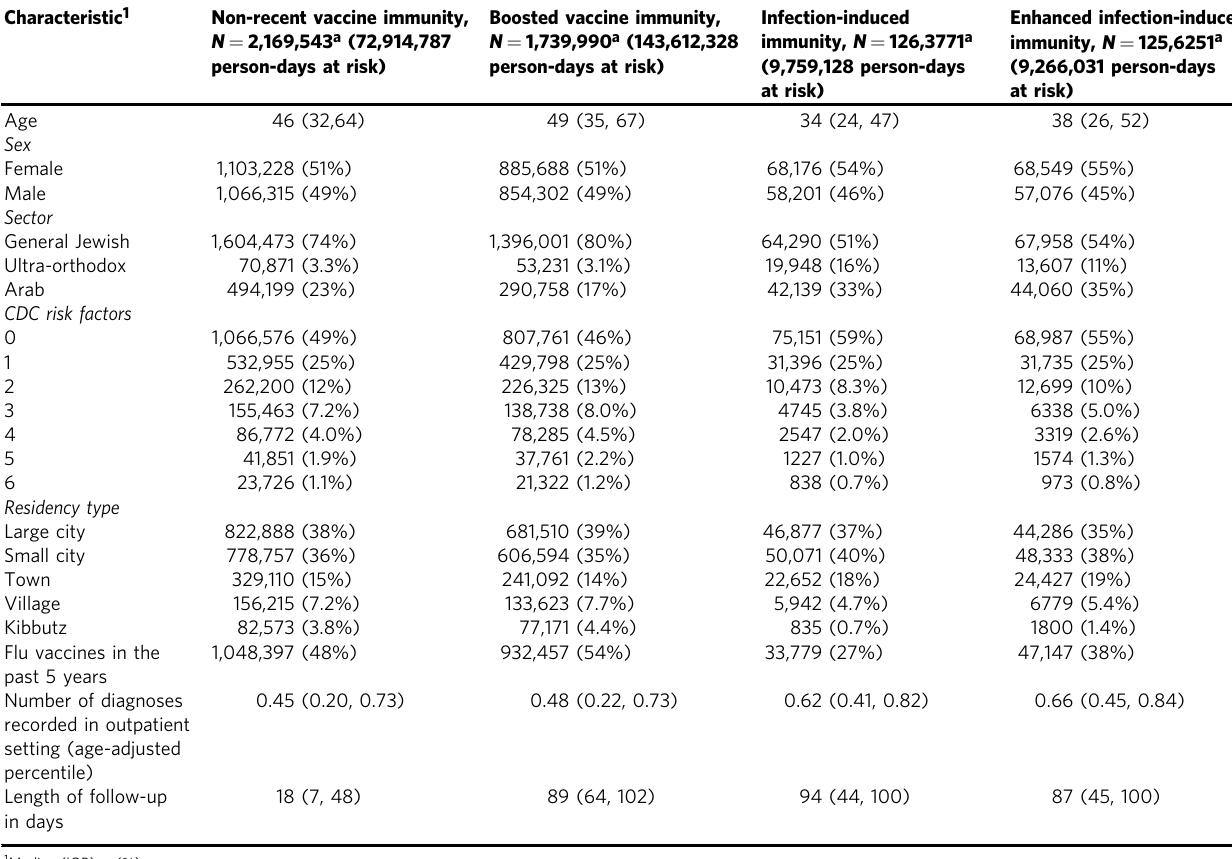
Table 1 Baseline characteristics of study population following application of all eligibility criteria.